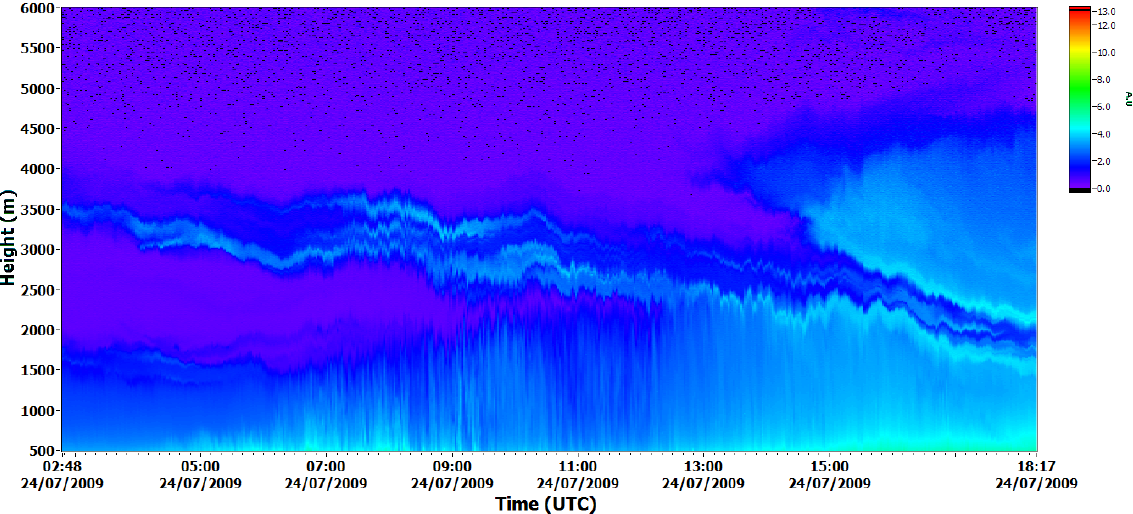
Fig. 5. Temporal evolution of the range-corrected lidar signal (in arbitrary units: A.U.) at 1064nm as obtained by the NTUA Raman lidar system on 24 July 2009 (02:48–18:17 UT).